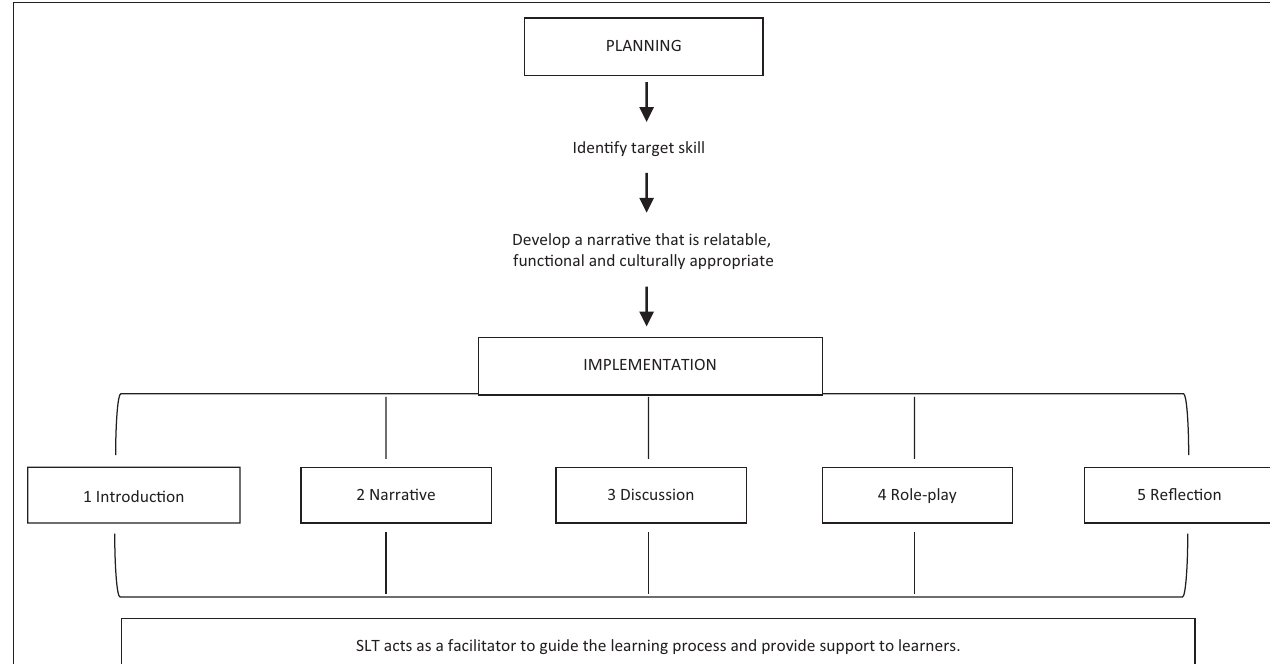
FIGURE 2: Recommended steps for planning and implementing role-play as a therapy